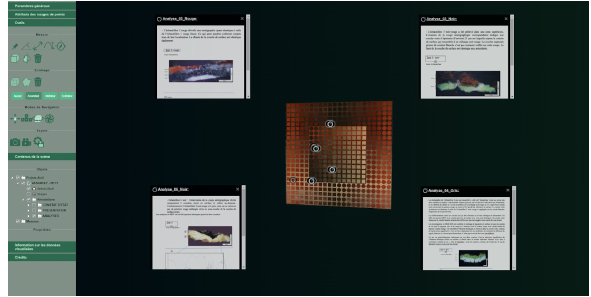
Figure 5 . Complementary analysis linked to spatial annotation as joint-resources on Potree-based viewer exported from “Zett” Aioli